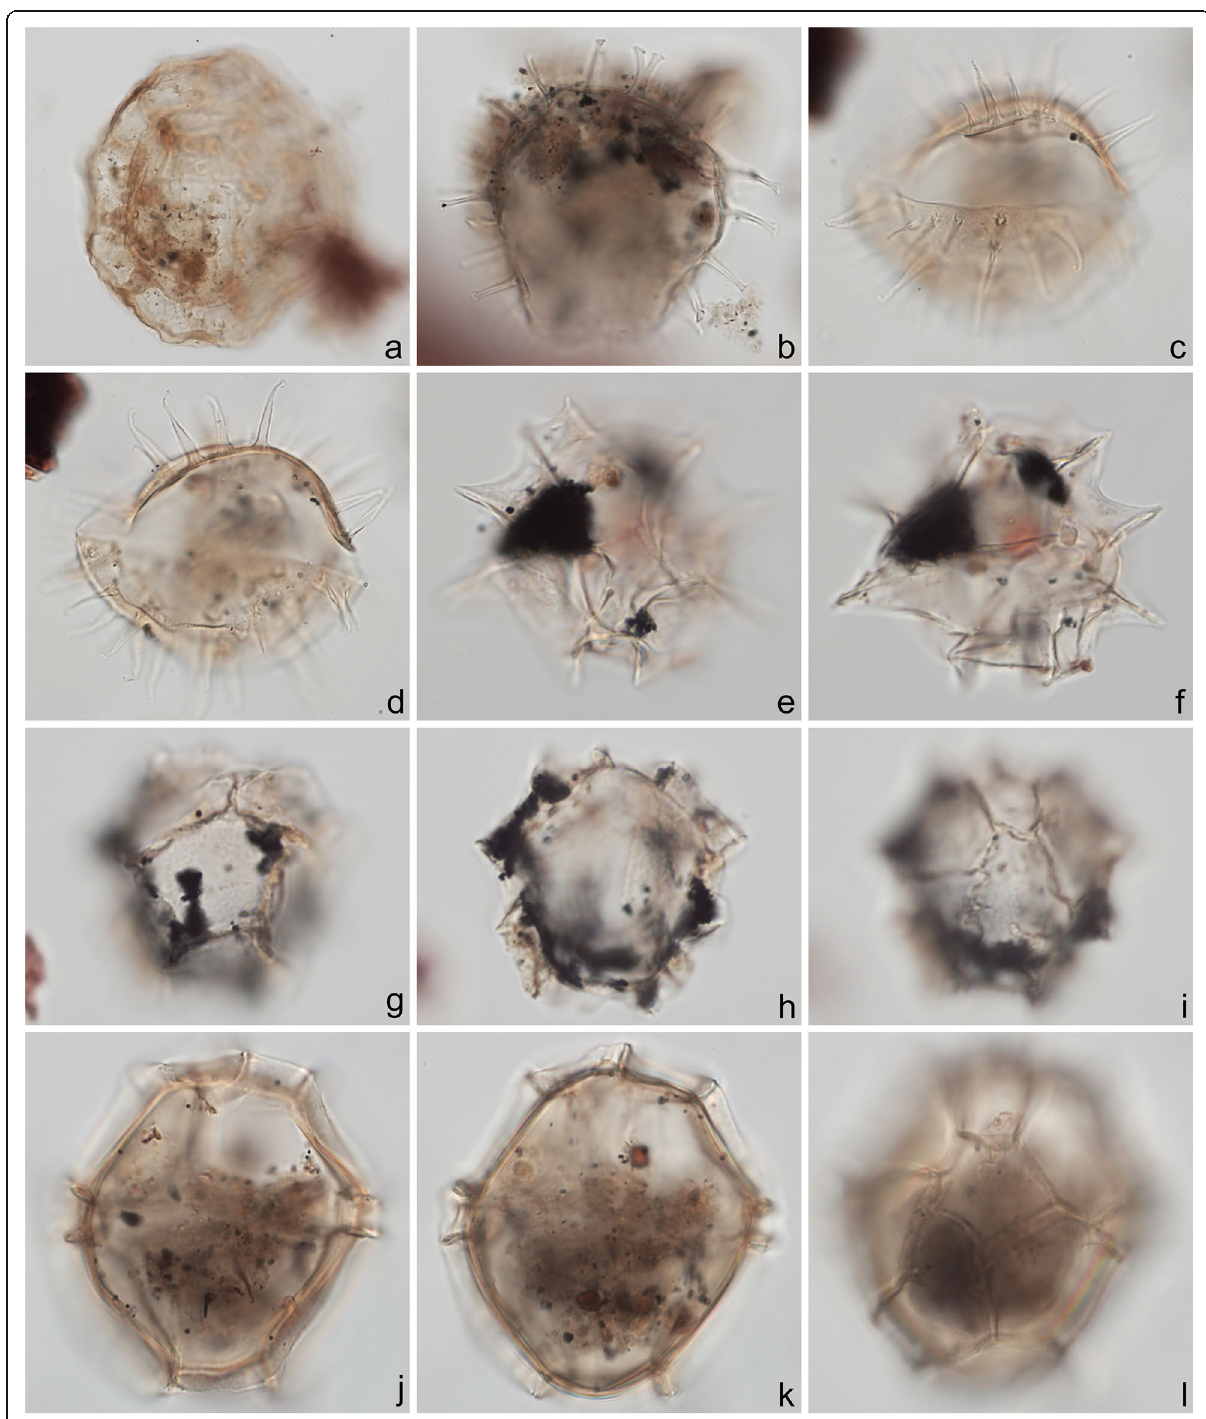
Fig. 4 Dinoflagellate cysts from the Chiba composite section. Max. dia. = maximum diameter. EF = England Finder reference. a Tuberculodinium vancampoae , polar view at upper focus; cyst max. dia. 122 μ m; sample TB 16, slide 1 (20 μ m), EF E25/4. b Polysphaeridium zoharyi , apical view of hypocyst at upper focus; central body max. dia. 52 μ m; sample TB 98, slide 1 (10 μ m), EF E20/1. c , d Lingulodinium machaerophorum , dorsal view at upper and mid-foci; central body max. dia. 58 μ m; sample TB2 99, slide 1, EF E36/0. e , f Impagidinium aculeatum , uncertain view at upper- and mid-foci; central body max. dia. 35 μ m; sample TB2 26, slide 1, EF E20/3. g – i Impagidinium paradoxum , antapico-dorsal view at upper, mid-, and lower foci; central body length 26 μ m; sample TB2 30, slide 2, EF K26/3. j – l Impagidinium patulum , dorsal view at upper, mid-, and lower foci; central body max. length 63 μ m; sample TB 92, slide 1, EF